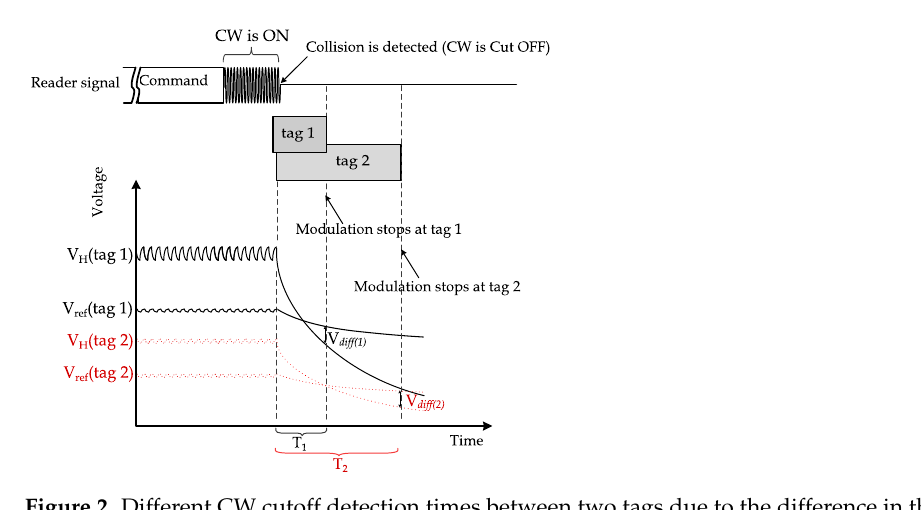
Figure 2. Different CW cutoff detection times between two tags due to the difference in the initial rectifier output voltage, V H .